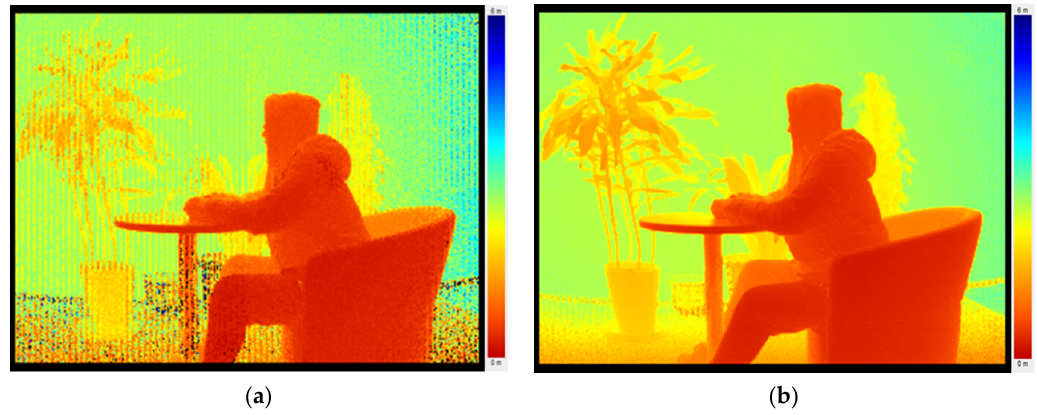
Figure 12. Results of depth image calibration. ( a ) Before calibration and ( b ) after calibration.